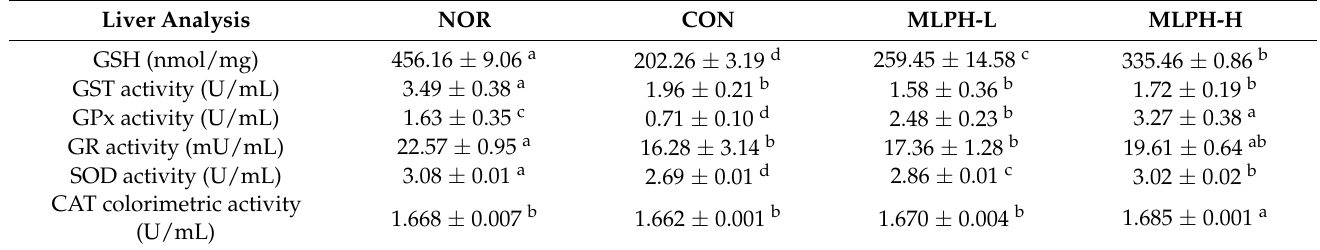
Table 3. Effects of 6 week treatment with low and high dose MLPH extract on hepatic antioxidant enzymes in ob / ob mice fed a standard diet.